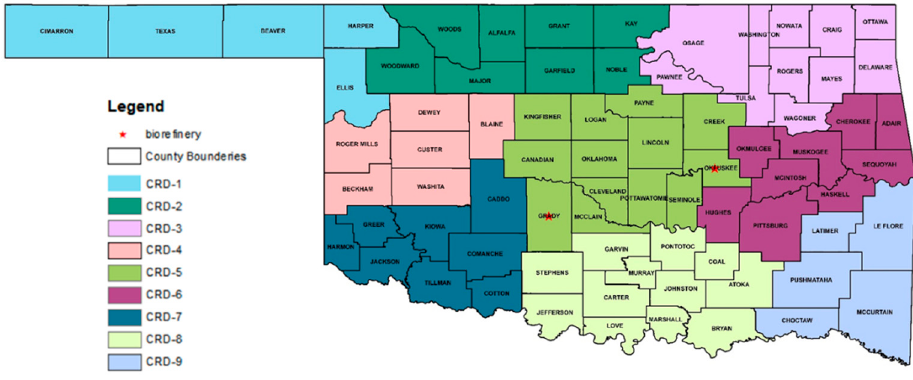
Figure 1. Study Region, Crop Reporting Districts (CRD), and Location of the Biorefineries.